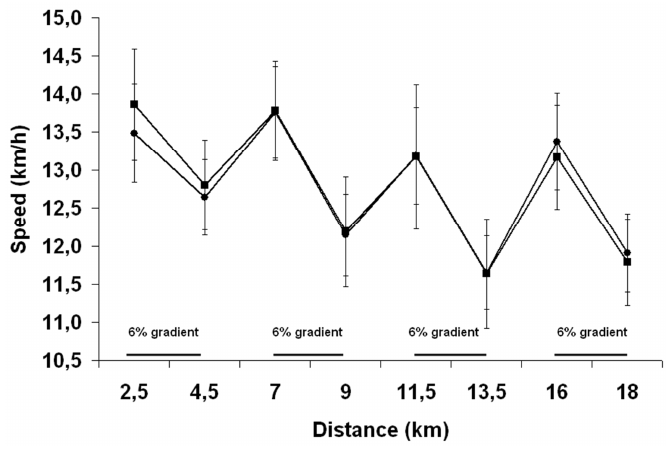
Figure 4. Change in running speed throughout the run with pre-exercise euhydration ( ■ ) and hyperhydration ( ● ). Results are mean ±